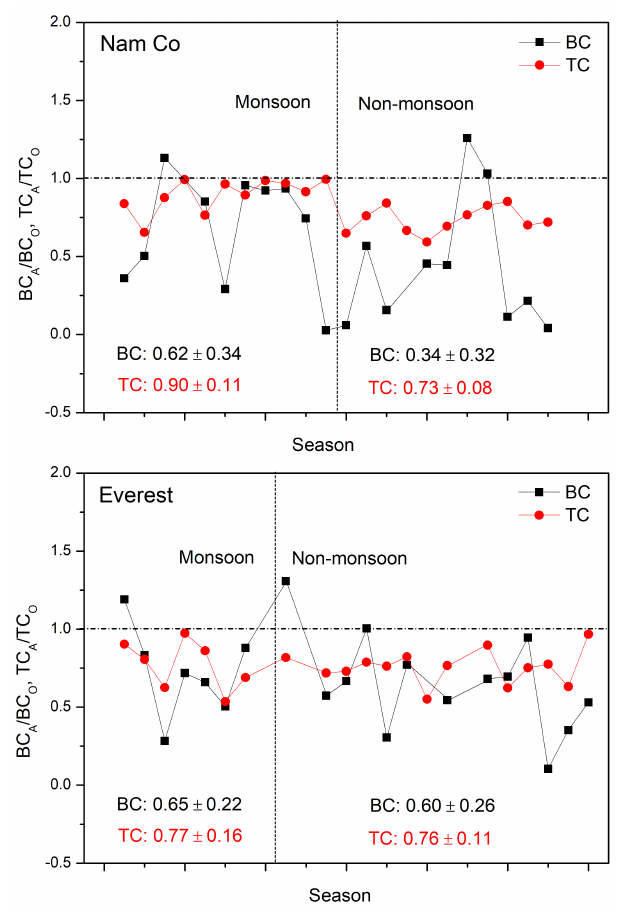
Figure 2. Seasonal variations in the BC and TC concentrations in the original and acid-treated aerosol samples collected at the Nam Co and Everest stations.